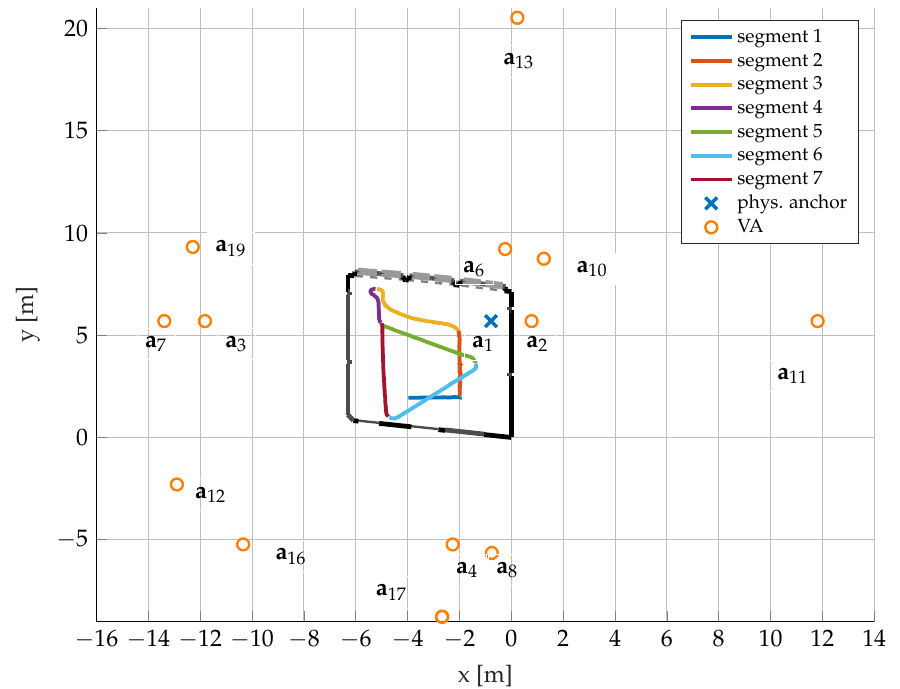
Figure 1. Floor plan of the evaluation scenario. Bold black lines denote walls, thick gray lines represent glass windows, other lines illustrate other materials. One blue cross represents the PA; orange circles denote VAs which were considered in the experimental evaluation. An agent moves along a trajectory segmented into seven parts indicated with distinct colors.